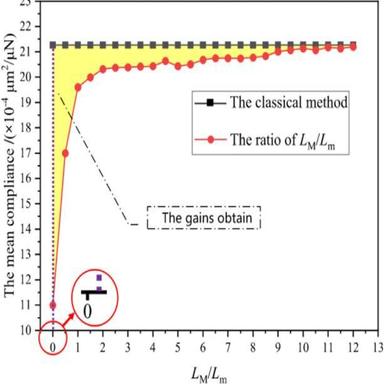
Constitutive constants for optimal RVE solids and L M /Lm.